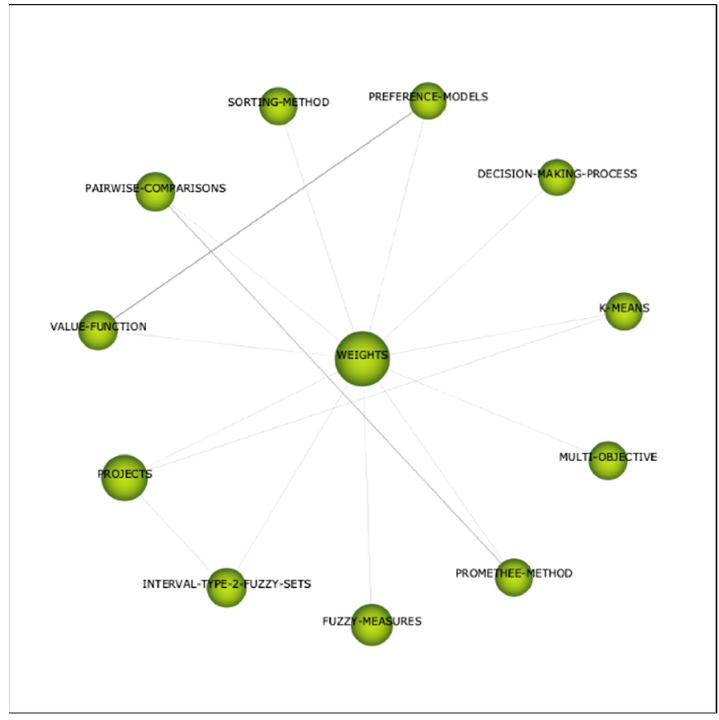
Figure A6. Weight cluster network.